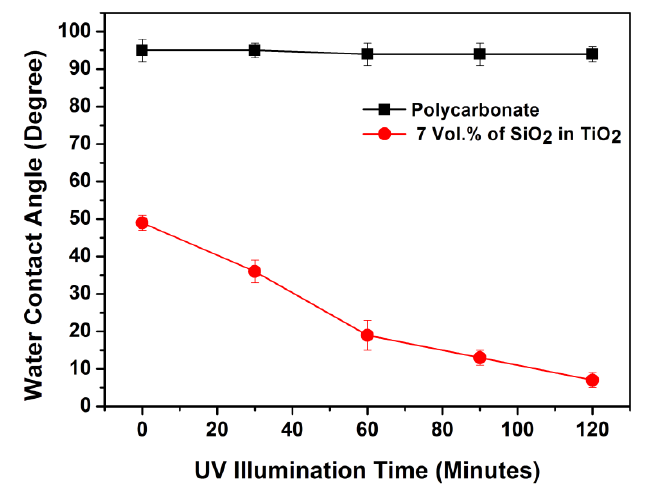
Figure 7. Wettability change on octadecyltrichlorosilane (ODS)-treated SiO under UV